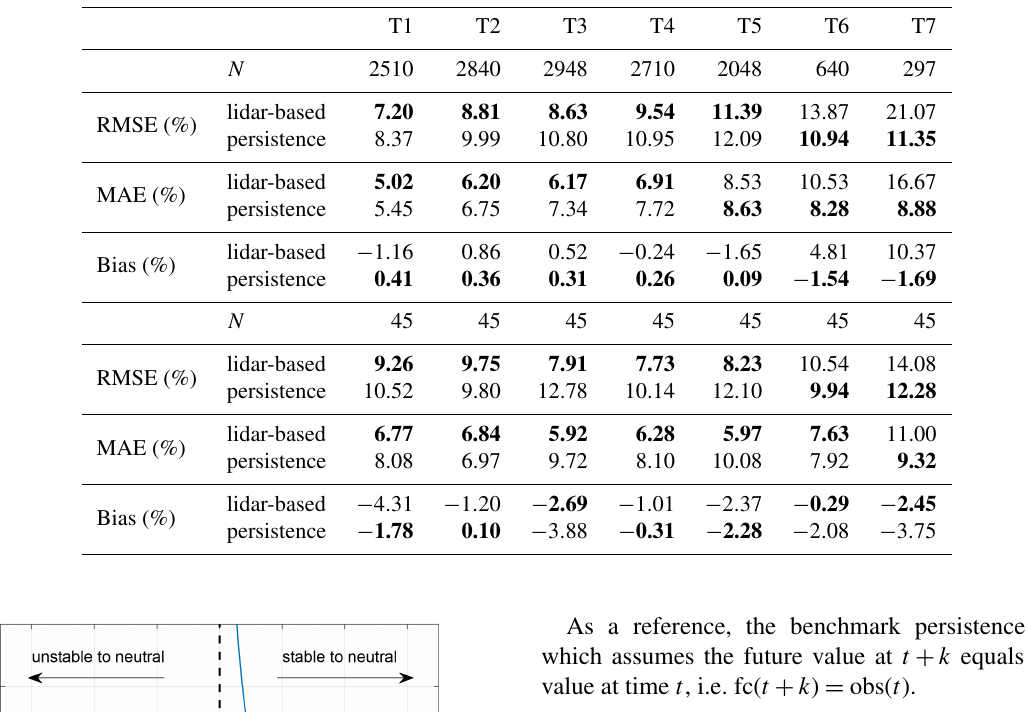
Table 1. Number of valid forecasts N , RMSE, MAE and bias for turbines T1–T7 for the lidar-based forecast and persistence during unstable stratification for all available forecasts and all simultaneously available ones. Scores are given in percent of the turbines’ nominal power with the lowest values in bold.